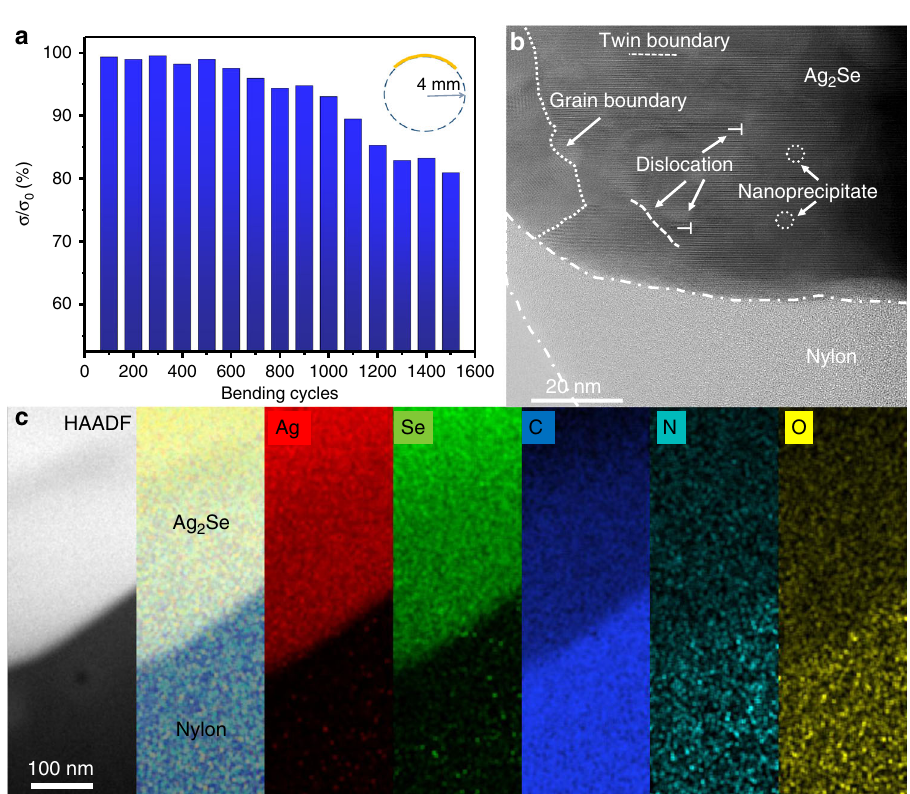
Fig. 3 Flexibility of the fi lm and evaluation of the heterointerface. a The ratio of electrical conductivity of the fi lm before and after bending as a function of bending cycles. b HRSTEM image showing good combination between the Ag 2 Se fi lm and nylon membrane. c From left to right: HAADF image of